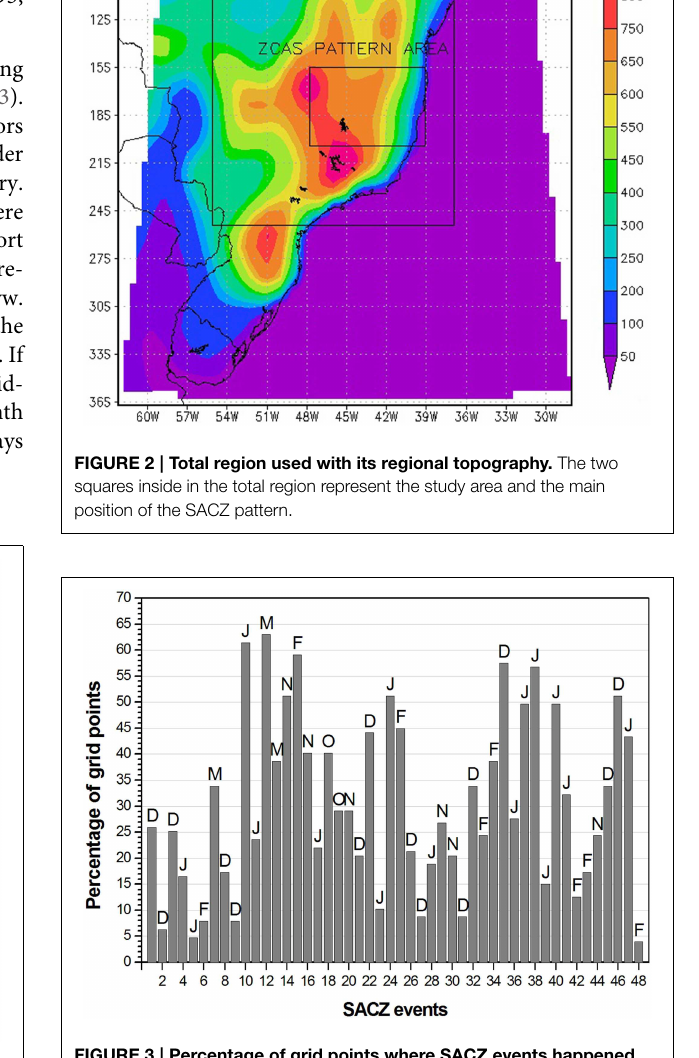
FIGURE 1 | SACZ event percentage from November to March.